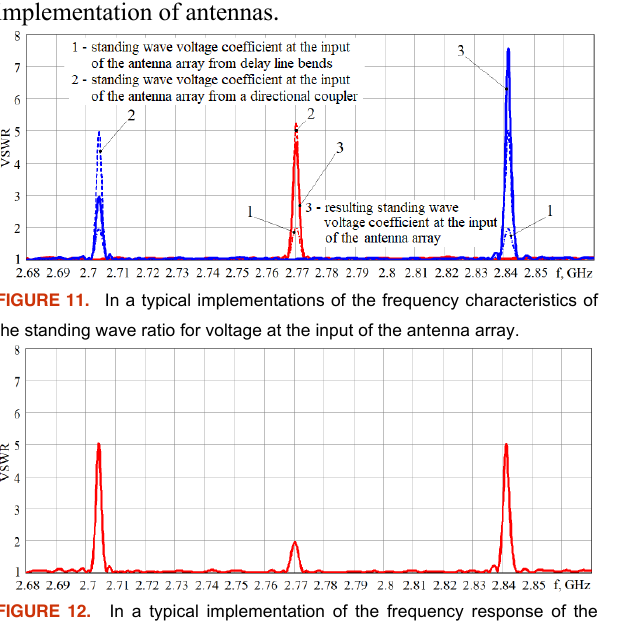
FIGURE 12. In a typical implementation of the frequency response of the standing wave ratio for voltage at the input of the antenna array with a shift of even and odd groups of directional couplers relative to each other by λgn/4, there is no shift between the even and odd bends of the delay